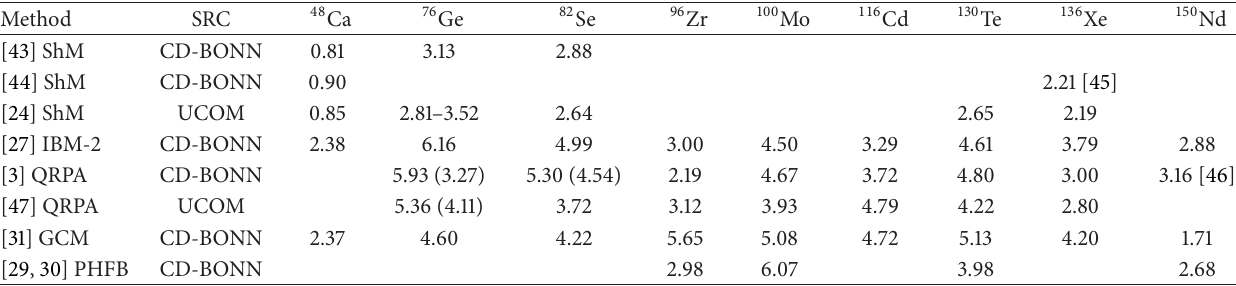
Table 1: The NMEs obtained with different methods. The values are obtained using an unquenched value for 𝑔 𝐴 and softer SRC parametrizations, which are specified in the second column.